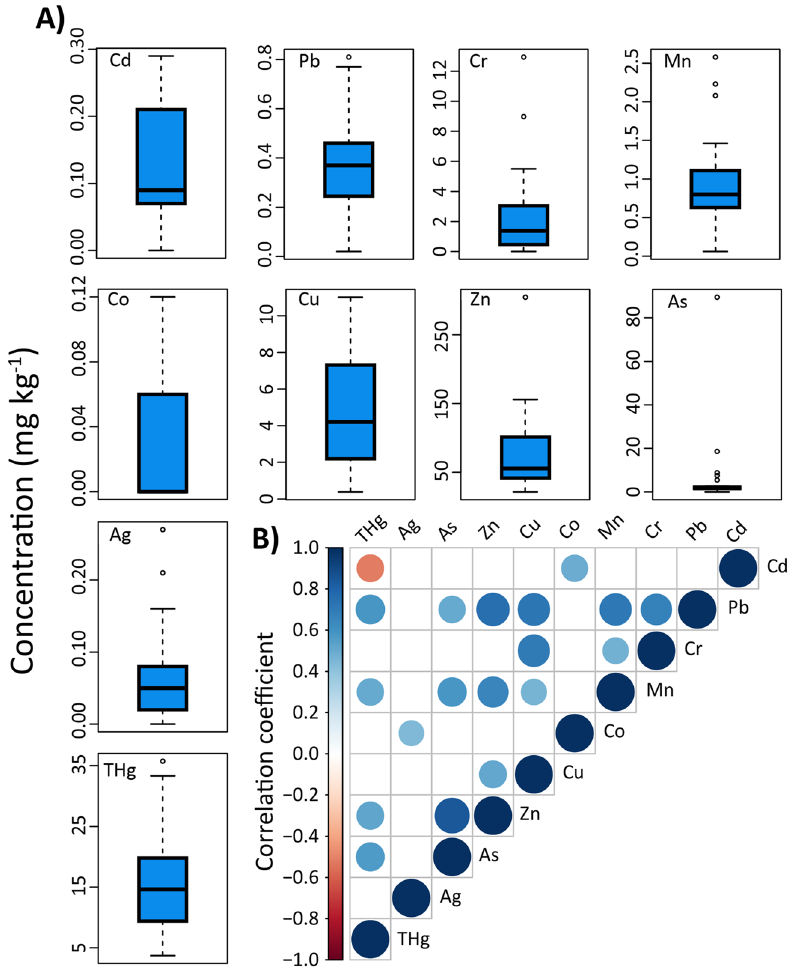
Figure 2. ( A ) Box and whisker plots highlighting the distribution of measurements for metals (mg kg −1 , DW). Solid horizontal line represents the median, box limits are 1st and 3rd quantiles, whiskers are 1.5 times the interquartile range, and circles represent outliers. ( B ) Correlograms highlighting Spearman’s correlation tests assessing covariance between trace metal concentrations in Caribbean Reef sharks. Circles represent significant correlations at alpha = 0.05 level, size of circles scales with size of correlation (i.e., larger circles indicate higher correlation coefficient) coefficient and colors ramp illustrates whether correlations are positive (blue) or negative (red). See Table 2 for sample sizes associated with each statistical comparison. Correlograms were created in the R package “corrplot” (Wei and Simko, 2017).